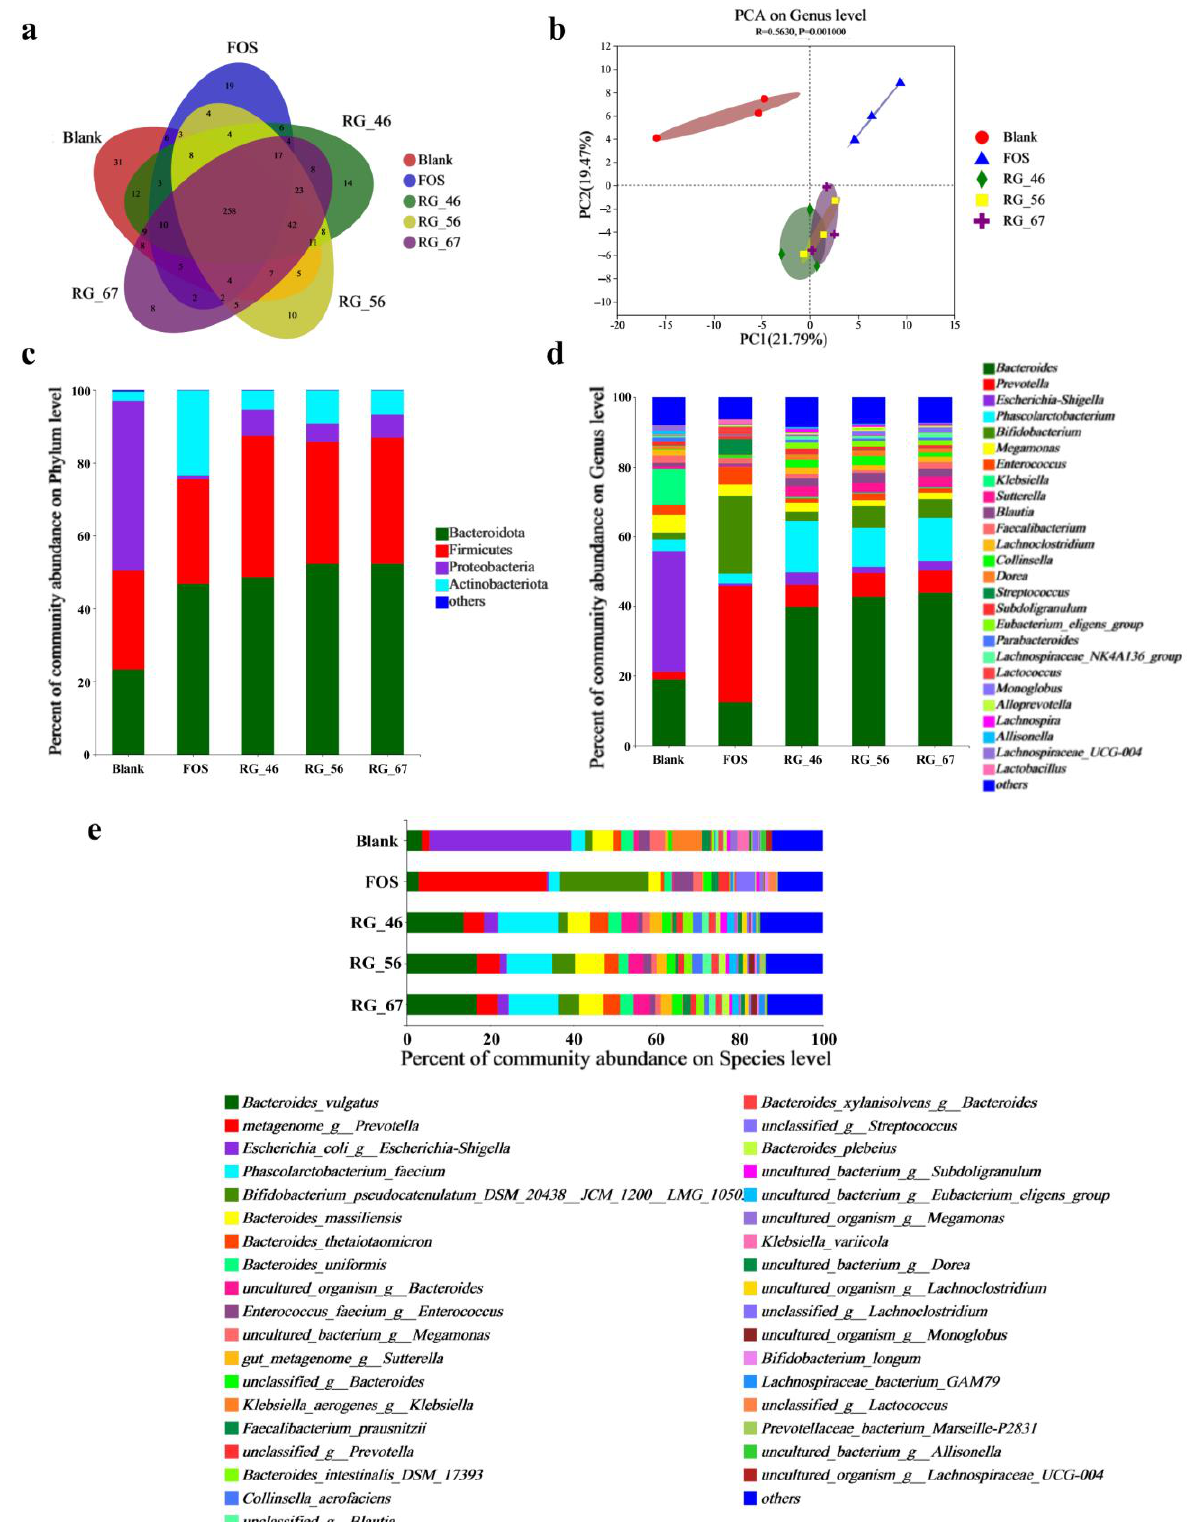
Figure 3. Composition analysis of gut microbiota. ( a ) Venn diagram of OTUs; ( b ) the result of the principal component analysis at the genus level; ( c – e ) the relative proportions of community abun- abundance at the phylum, genus, and species dance at the phylum, genus, and species levels.